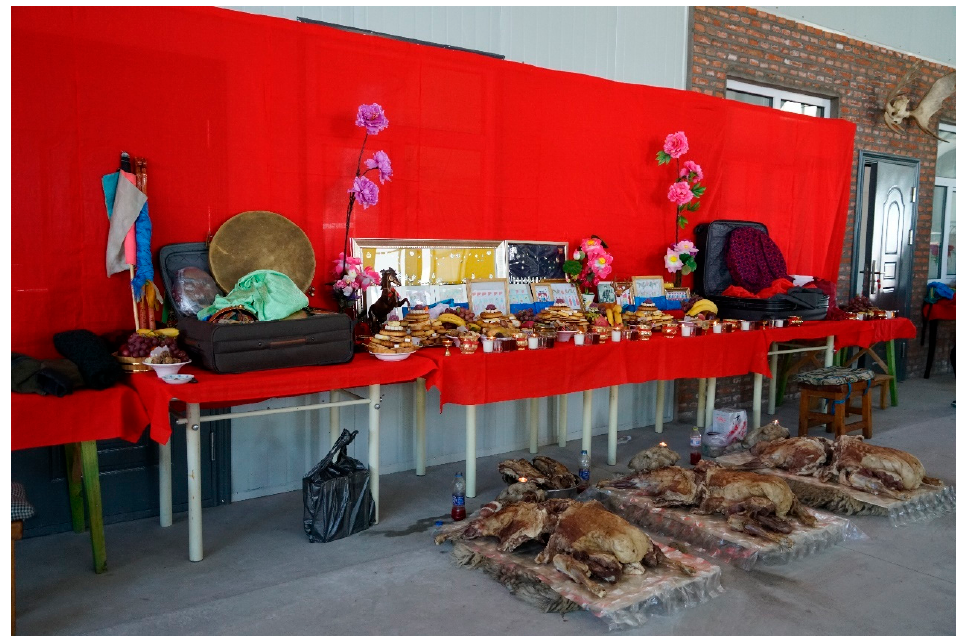
Figure A5. Sacrifices dedicated to the ancestors (On 2 June 2017, the ritual to offer sacrifices to the ancestral spirit of Enen Duola). Photo: Minna Sa, 2017.